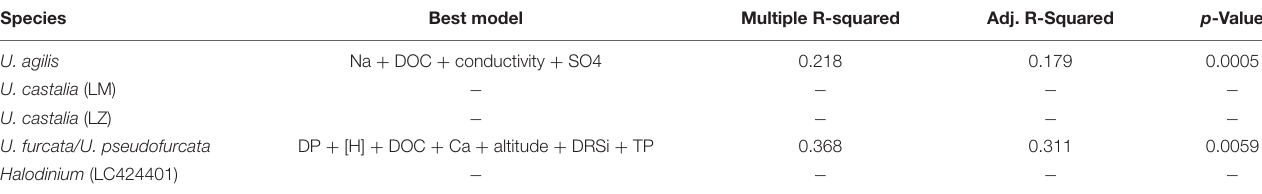
TABLE 4 | Best models of multiple linear regression analyses to explain the relationship between environmental parameters and Urotricha abundance data. Species Best model Multiple